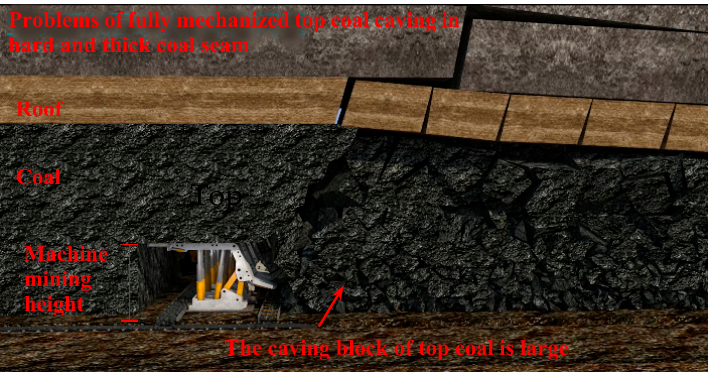
Figure 6. Top coal caving schematic diagram of fully mechanized top coal caving in hard and thick coal seam.